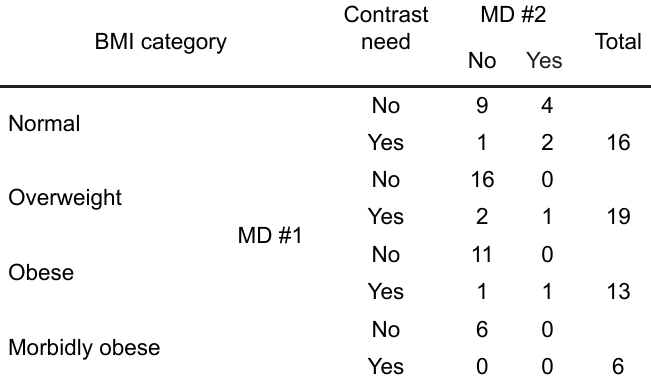
Table. Spreadsheet compiling the grader’s data, from which Kappa analysis was